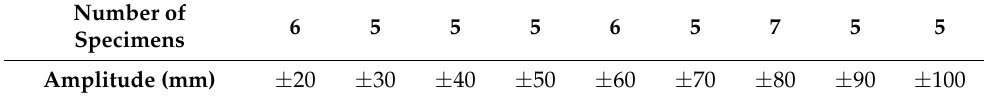
Table 1. Pipe element test cases.